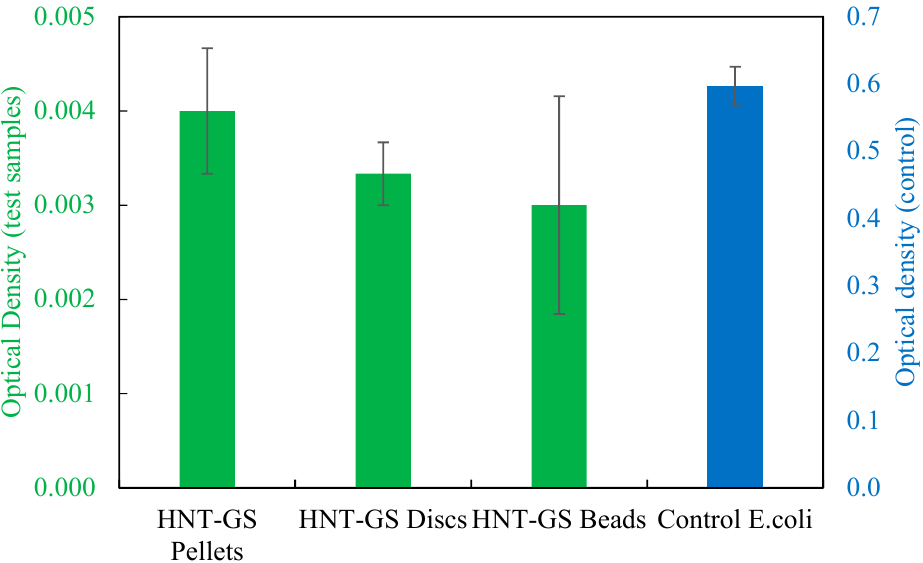
Figure 8. Optical densities of different HNT-GS constructs against E. coli (mean ± SD, n = 3) measured at 600 nm.